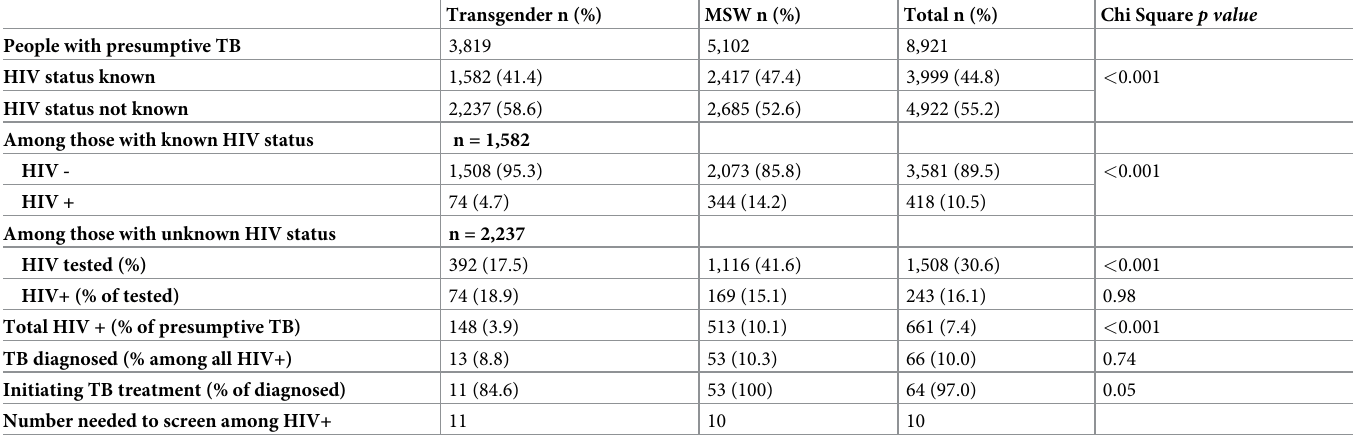
Table 2. HIV screening and testing among those identified as presumptive for TB, Sindh